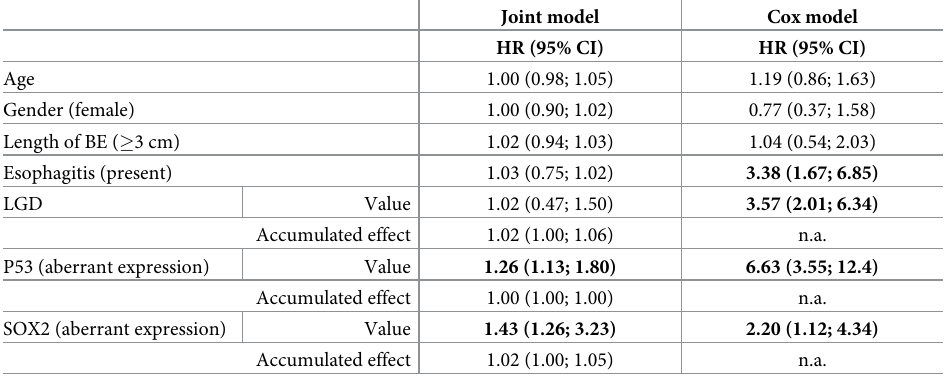
Table 3. Risk of neoplastic progression. For every biomarker normal expression is the reference category. HR > 1 is associated with an increased risk; HRs of joint model represent the HGD/EAC risk if the risk of aberrant expression in the longitudinal course of a biomarker changes with 10%, HRs of the Cox model represent the HGD/EAC risk if aber- rant expression is present at